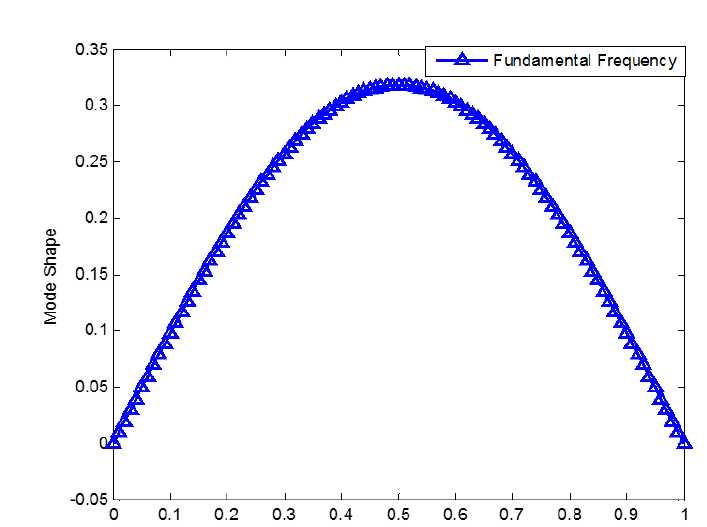
Figure 3. Fundamental mode shape of simply supported condition at both